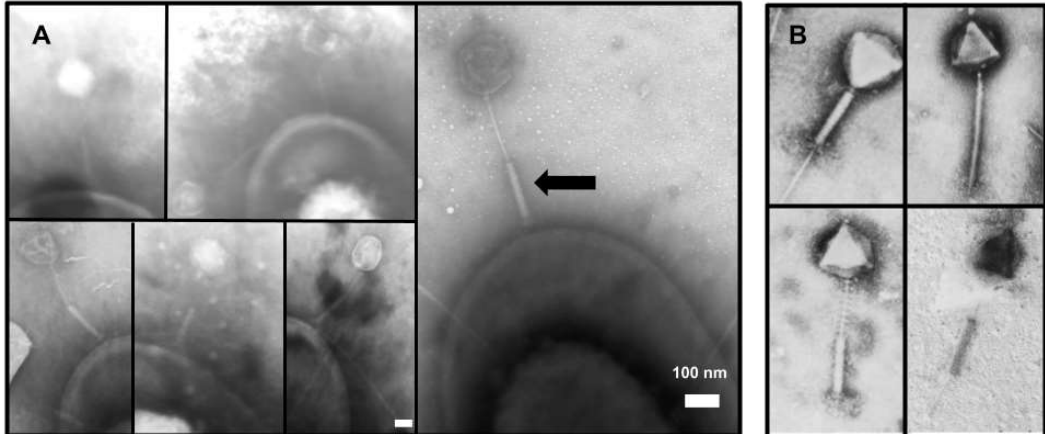
Figure 1. TEM of negatively stained phage G showing multiple states of the contractile sheath. ( A ) Phage G particles attached to the host cell and ( B ) Micrographs of phage G virions, reproduced from Ageno et al. 1973 [12]. In ( A ), all host cell-adsorbed phage G particles had the tail sheath contracted toward the head–distal tip, which was in contact with the host cell surface. The arrow indicates an example of one sheath contracted in this atypical manner. The white bar represents 100 nm in length. In ( B ), images from [12] show that the phage G tail sheath contracted at different positions along the tail (next to the head, at the middle of the tail, and near the tail tip), demonstrating the atypical behavior of the phage G sheath that we observed both by negative stain TEM and cryo-EM (see below). Images in ( B ) used with permission from Elsevier, Copyright (1973).